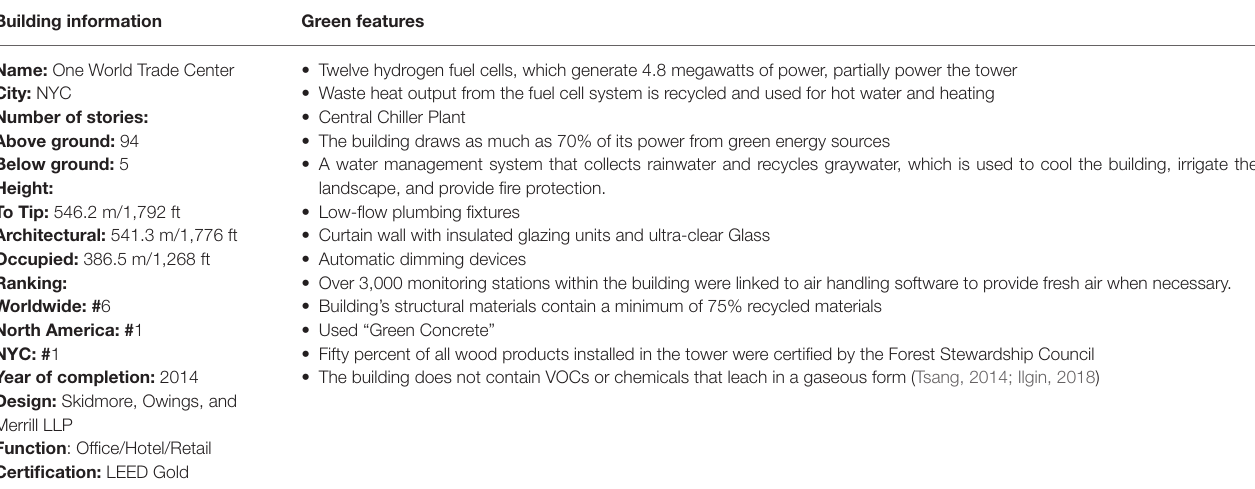
TABLE 3 | One World Trade Center: Key green features. Building information Green features